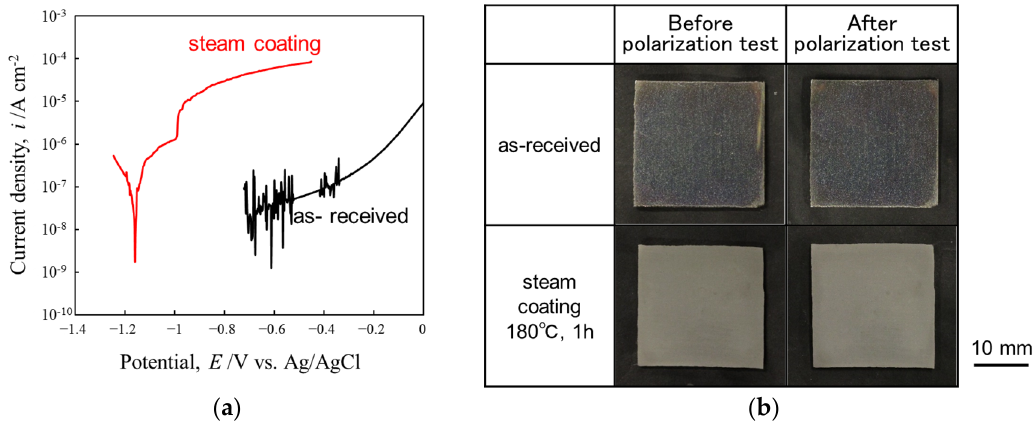
Table 3. The E corr and i corr values for the anticorrosive-film-coated Al-Mg-Si alloy were estimated to be − 1.16 V vs. Ag/AgCl and 8.2 × 10 − 8 A cm − 2 , respectively. These results were interpreted as implying,